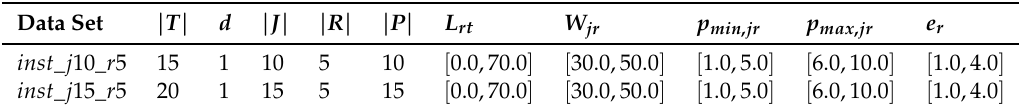
Table 3. Instance datasets parameters.